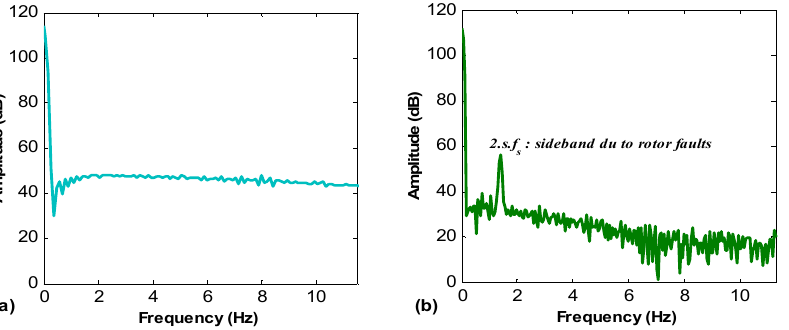
Figure 6. Park’s vector spectrum: ( a ) healthy motor and ( b ) motor with one BRB (experimental result).